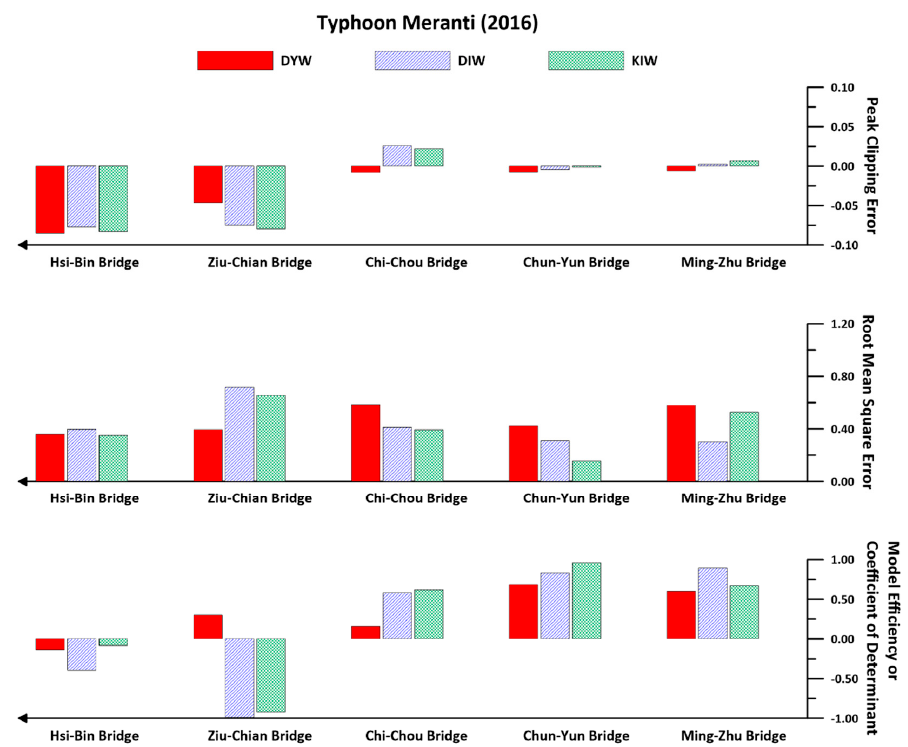
Figure 12. DYW/DIW/KIW simulation errors for Typhoon Dujuan (2015). Water 2018 , 10 , x FOR PEER REVIEW